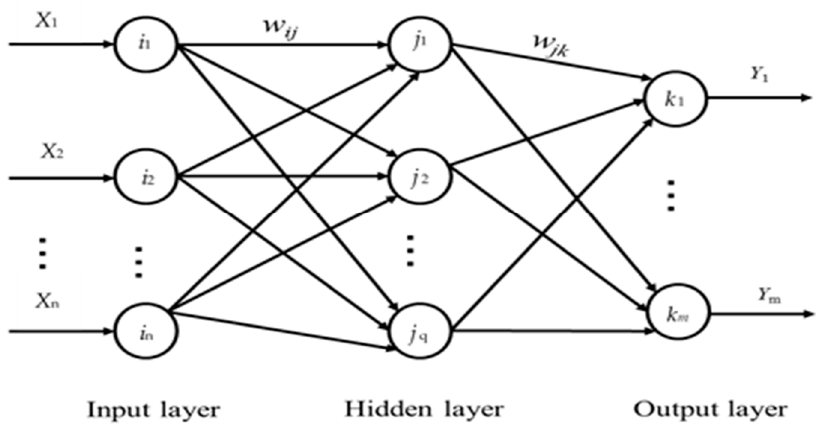
Figure 5. Topology diagram of backpropagation (BP) neural network.